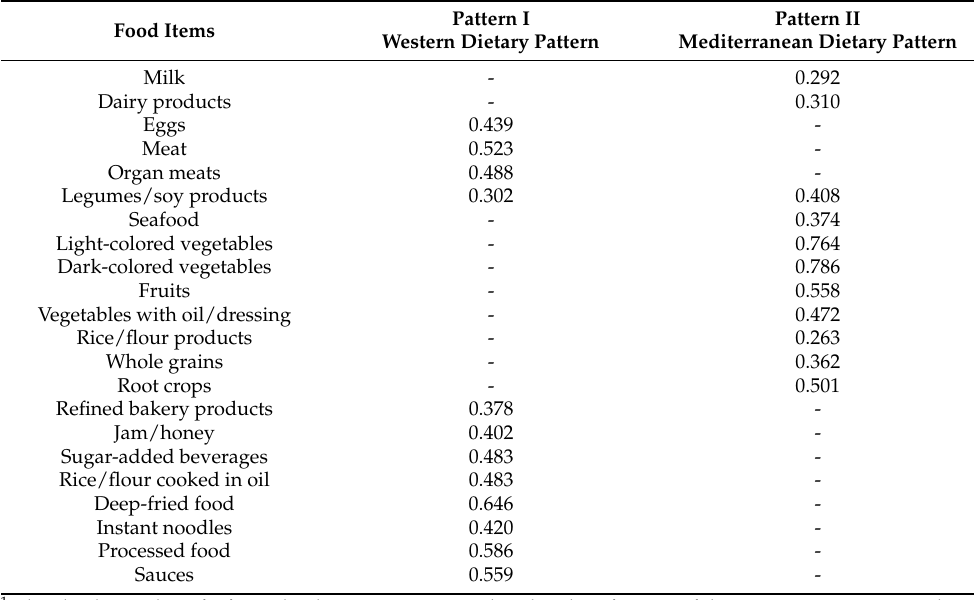
Table 1. Factor loadings of two dietary patterns identified by principal component analysis 1